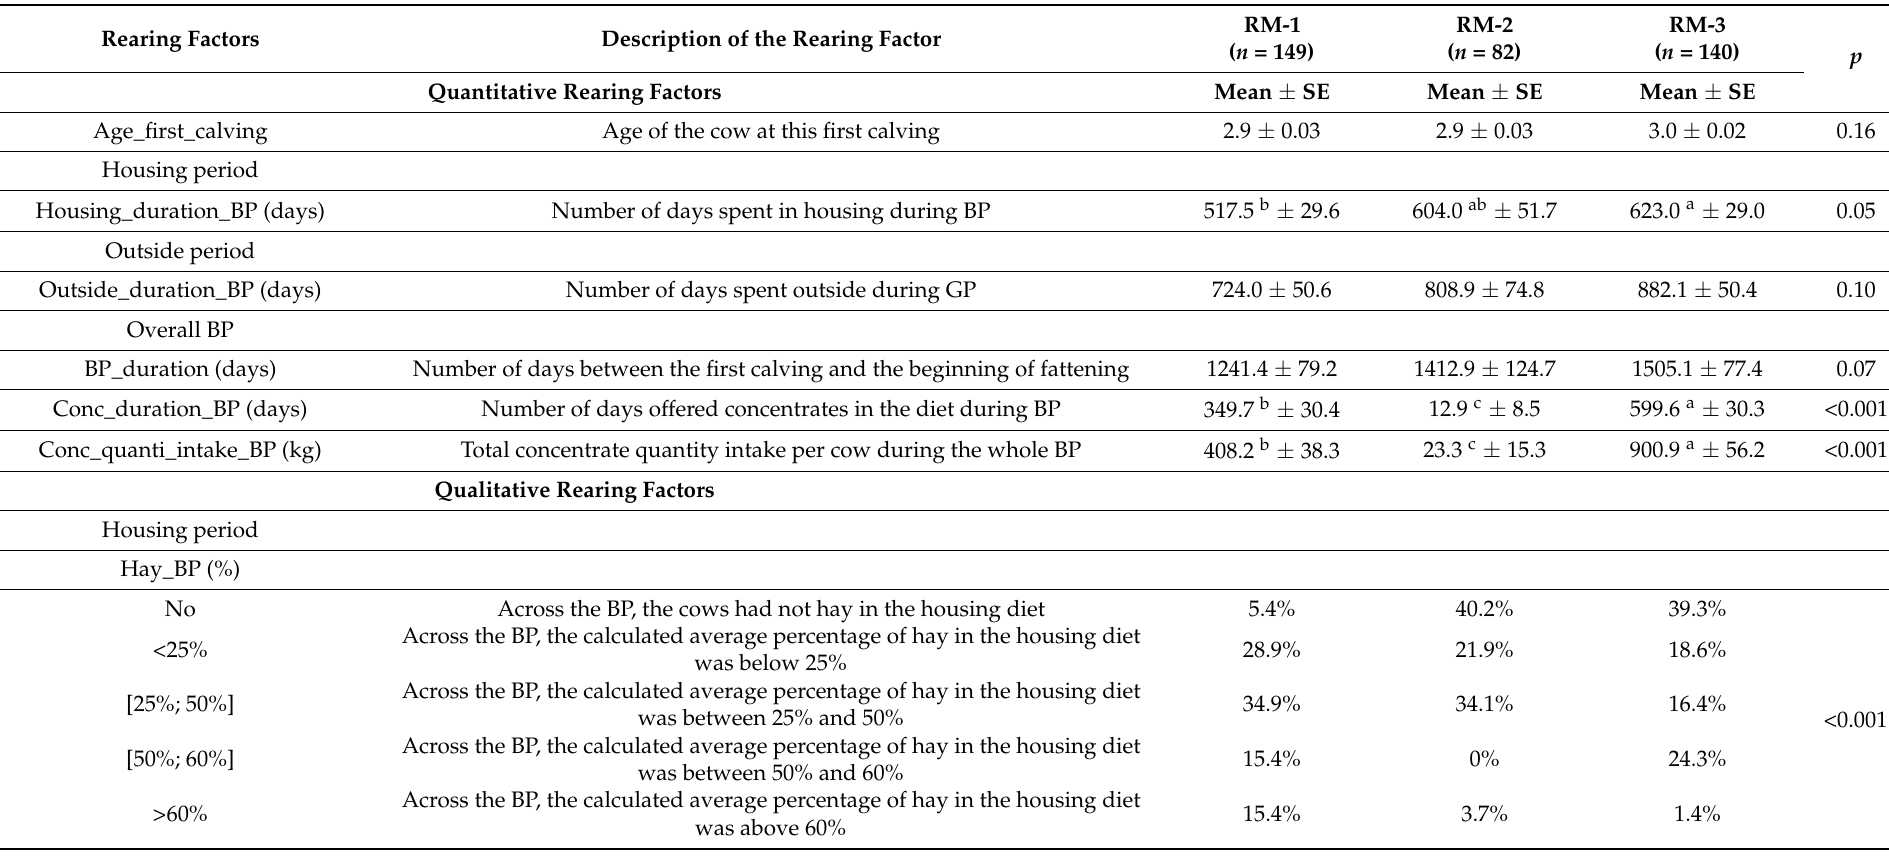
Table 5. Rearing factors characterizing the breeding period (BP) of the rearing managements (RM) applied during the cull cows’ whole